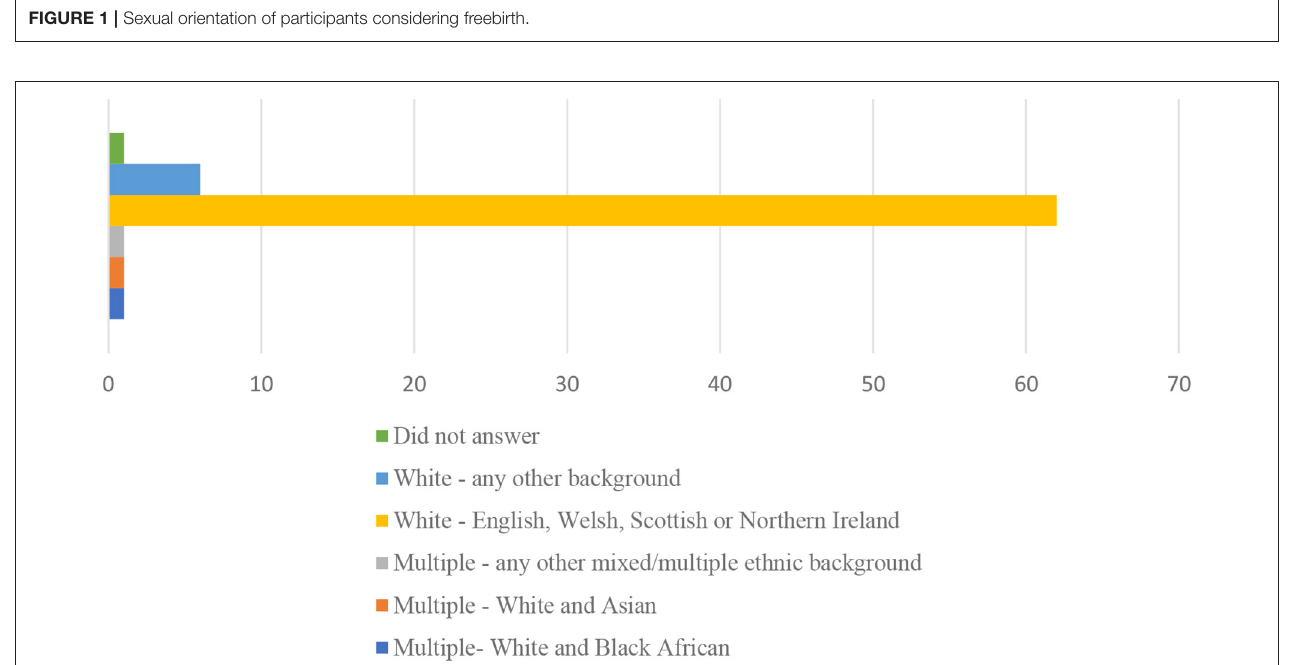
FIGURE 2 | Ethnicity of participants considering freebirth.